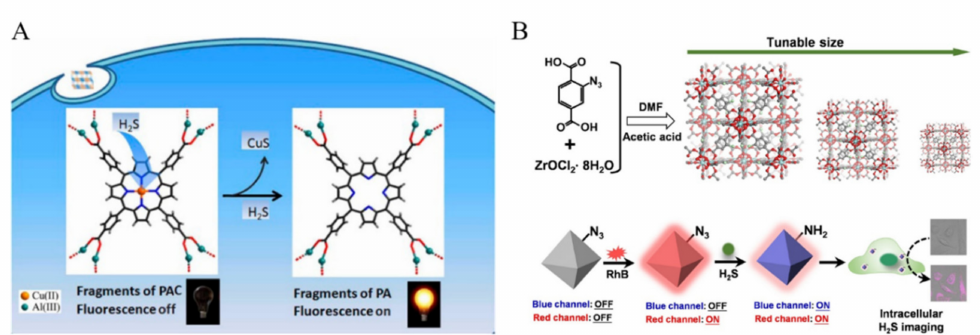
Figure 6. ( A ) Schematic illustration of structural fragment of nano-MOF PAC and the proposed strategy for fluorescent variation of PAC upon reactive Cu(II) ions as the H 2 S-responding site. Reproduced with permission [105]. Copyright 2014, American Chemical Society. ( B ) Schematic illustration of one-step hydrothermal synthesis of UiO-66-N 3 in acetic acid/DMF with tunable size, the principle of H 2 S detection on the basis of RhB/UiO-66-N 3 and their applications for intracellular H 2 S imaging. Reproduced with permission [106]. Copyright 2021,